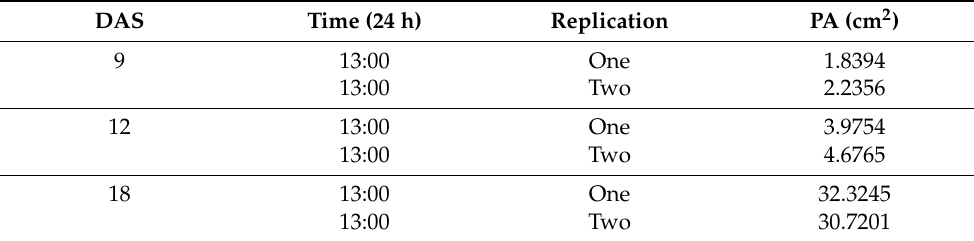
Table 1. Comparing projected area (PA) of green lettuce at fixed lighting condition (200 µmol ms –1 s –1 ) on multiple days after sowing (DAS) and time. Values in the same column followed by an asterix are significantly different ( p < 0.05).